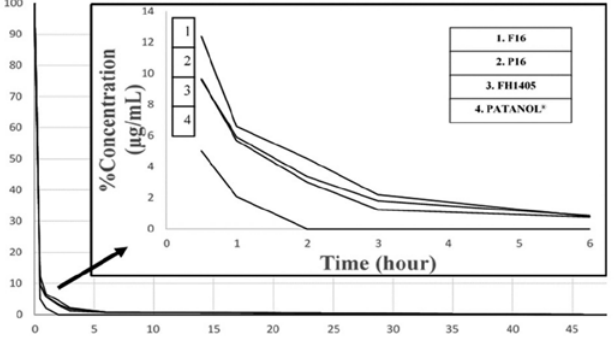
FIGURE 5 - Cumulative release percentage from gel formulations in simulated tear fluid (n=3).